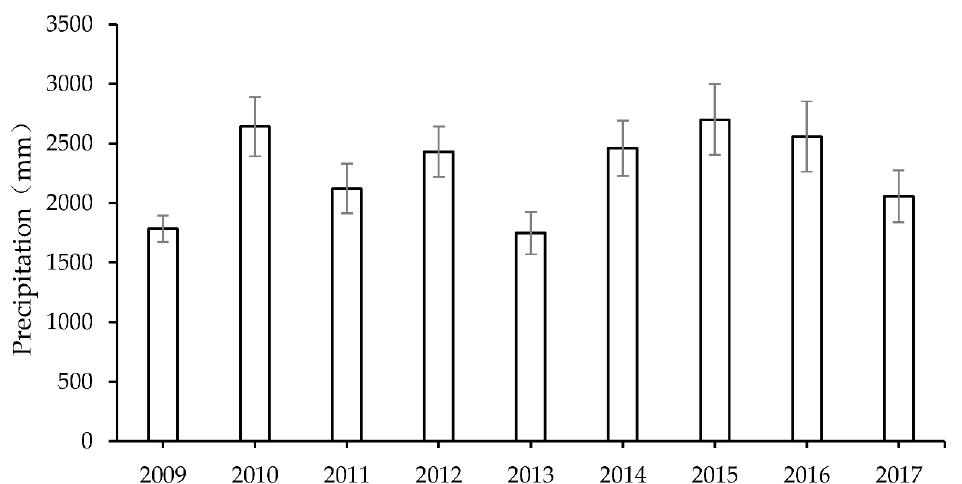
Figure A1. Mean annual precipitation in the Shuaishui River Basin: 2009–2017. The error bar shows ± one standard deviation of the annual average precipitation among the 13 rainfall stations.